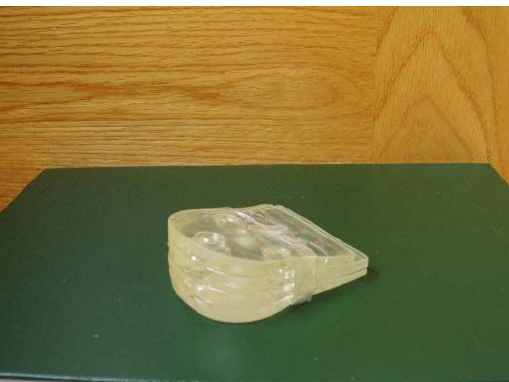
Figure 5. Randomized flow chart.